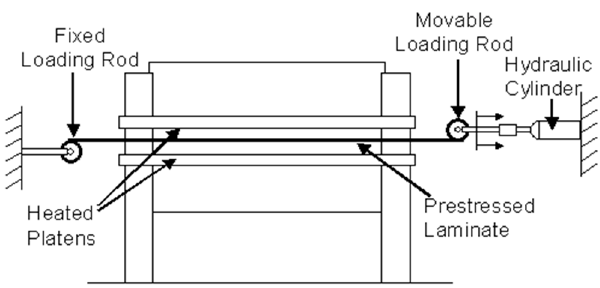
Figure 4. Schematic illustration of the hydraulic cylinder-based pre-stressing rig used by Tuttle et al. [38].